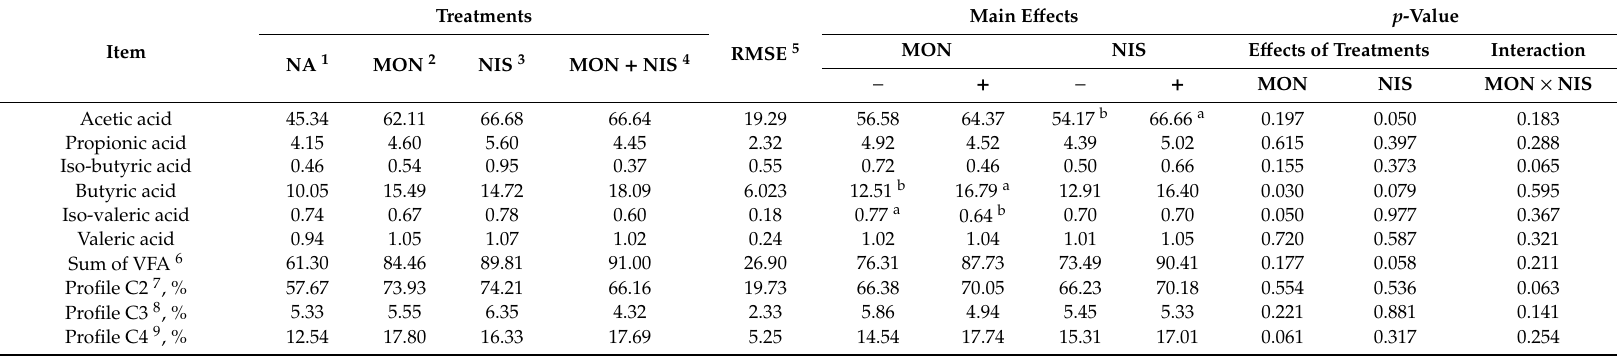
Table 7. The e ff ect of dietary supplementation of nisin alone or in combination with monensin on organic acid concentrations in the cecal content ( µ mol / g), Experiment 1.